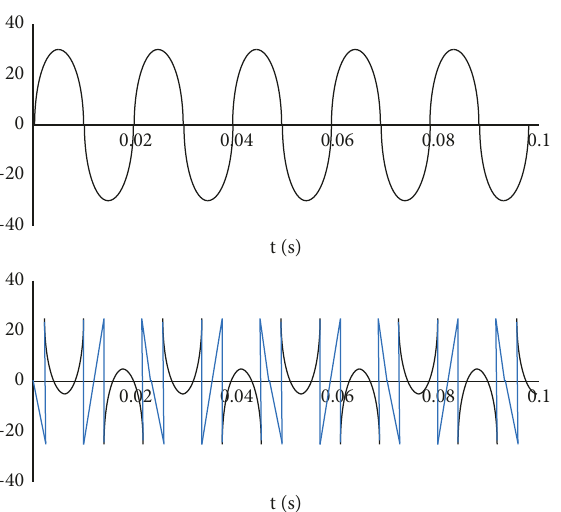
Figure 8: Comparison of A-phase compensation current and compensated current.